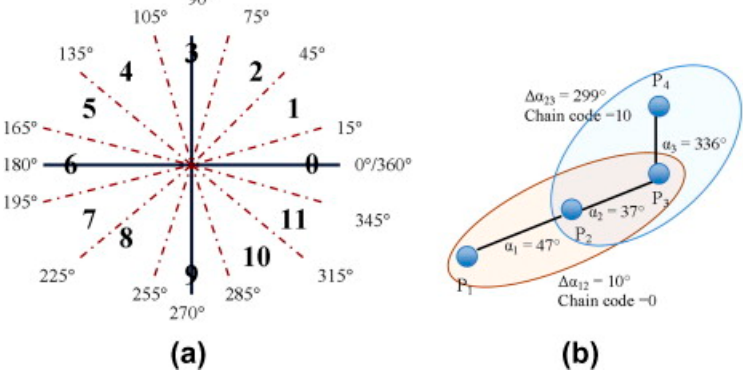
Figure 2. The 12-direction chain code ( a ); and an example ( b ), adopted from [38].